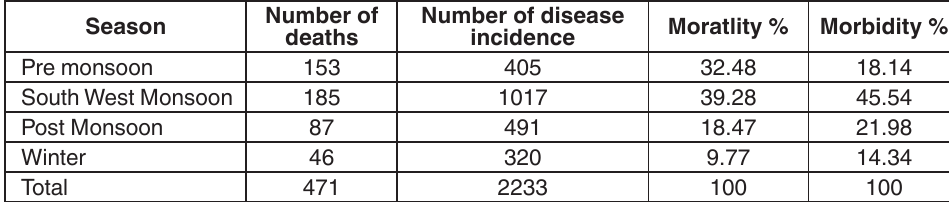
Table 2: Percent mortality and morbidity in different season